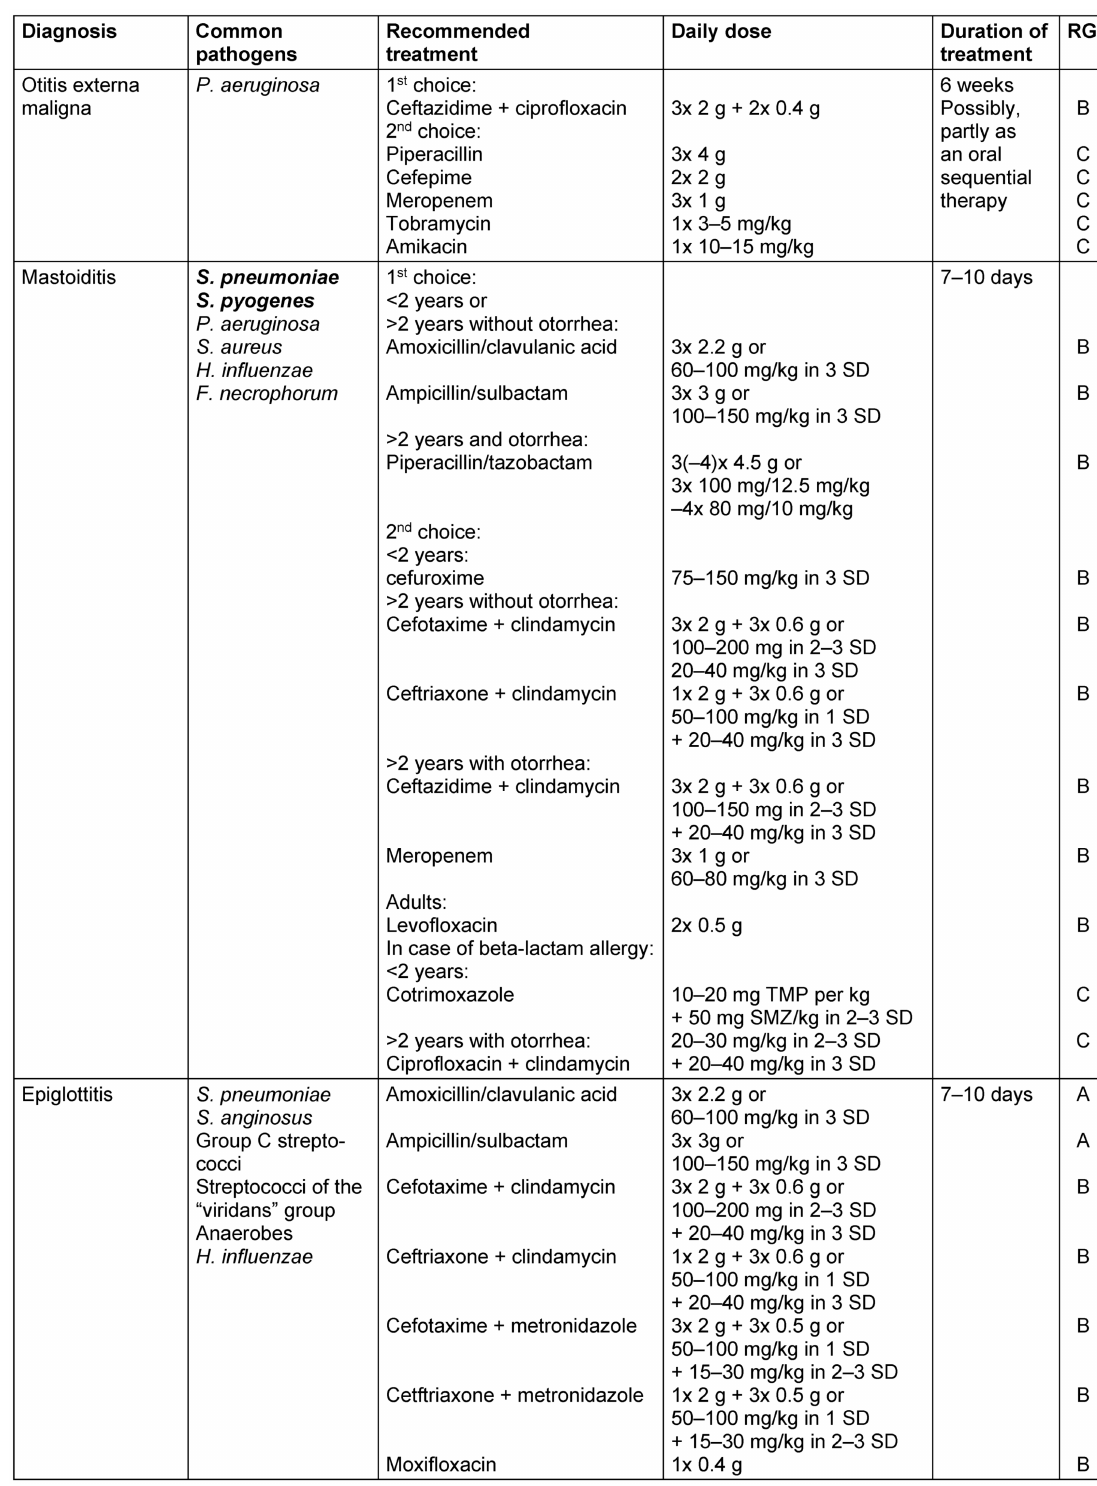
Table 1: Treatment